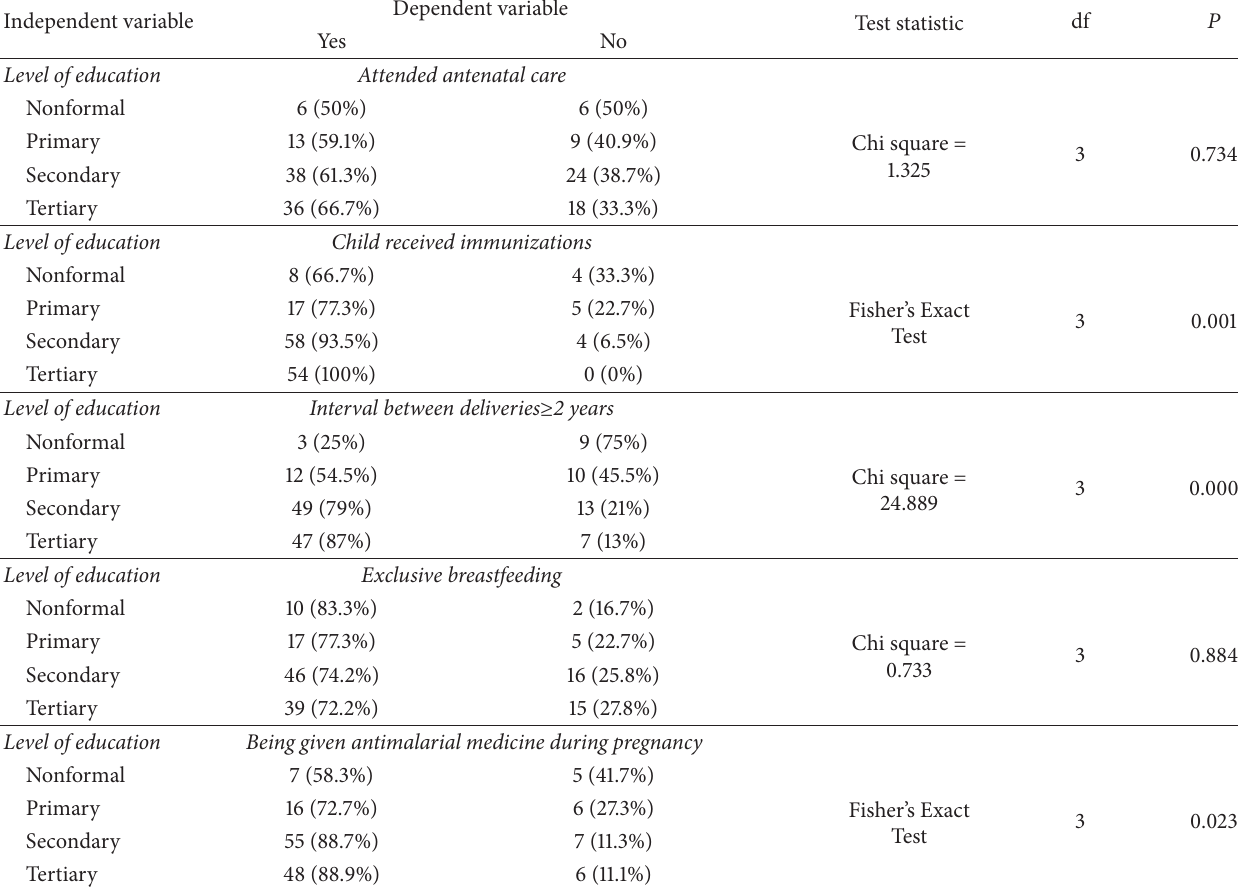
Table 7: Association between level of education and practice of child survival strategies.